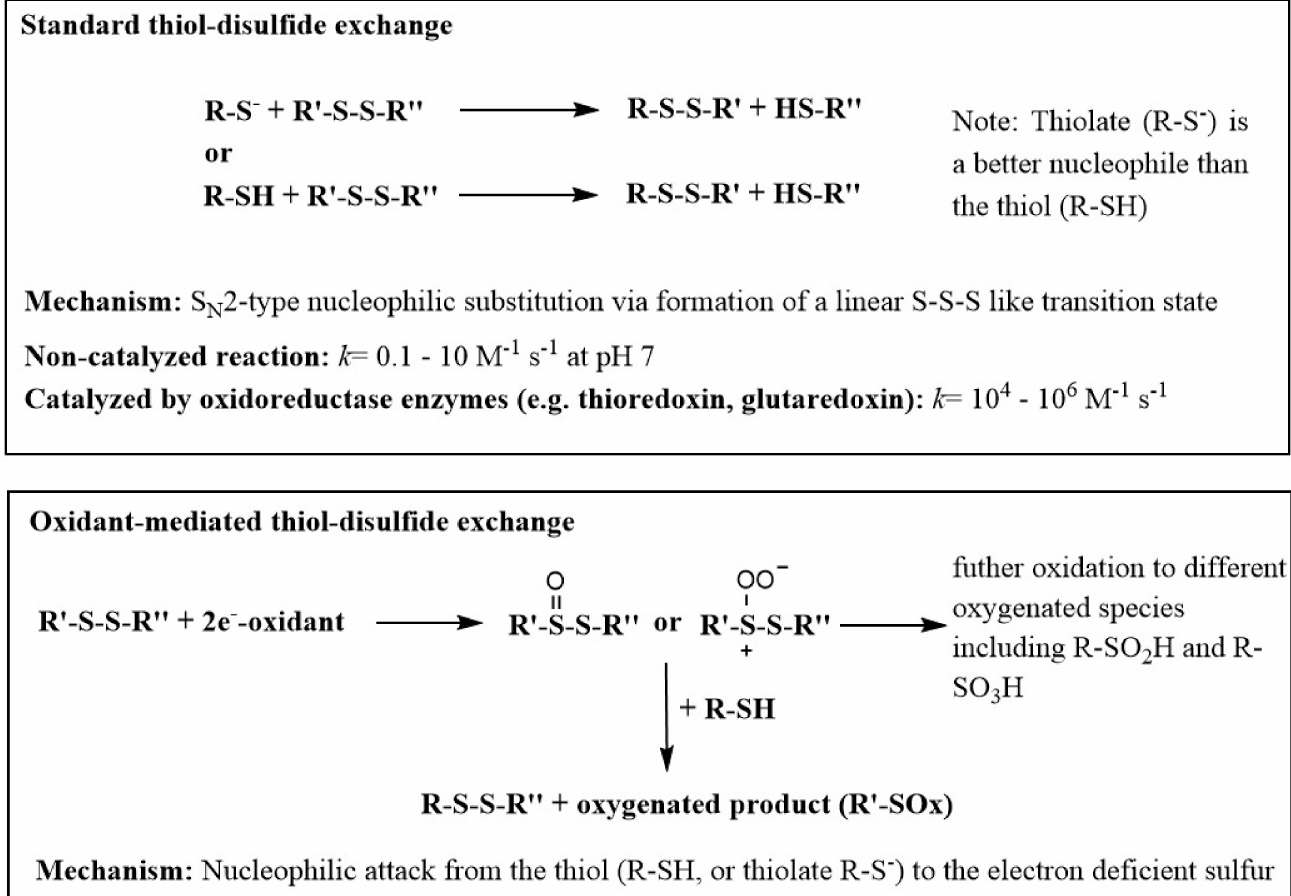
Figure 2. Mechanisms of traditional ‘thiol–disulfide exchange’ (top) and ‘oxidant-mediated thiol– disulfide exchange’ (bottom)